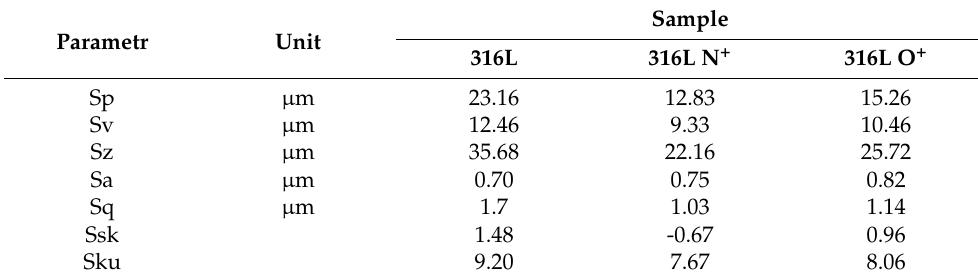
Figure 3. Axonometric images and surface profiles of the reference sample ( a ) and the samples implanted with nitrogen ions ( b ) and oxygen ions ( c ). Table 4. Amplitude